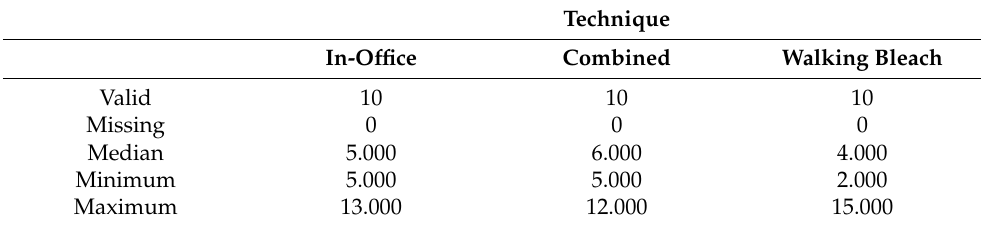
Table 3. The success of bleaching depending on the change in